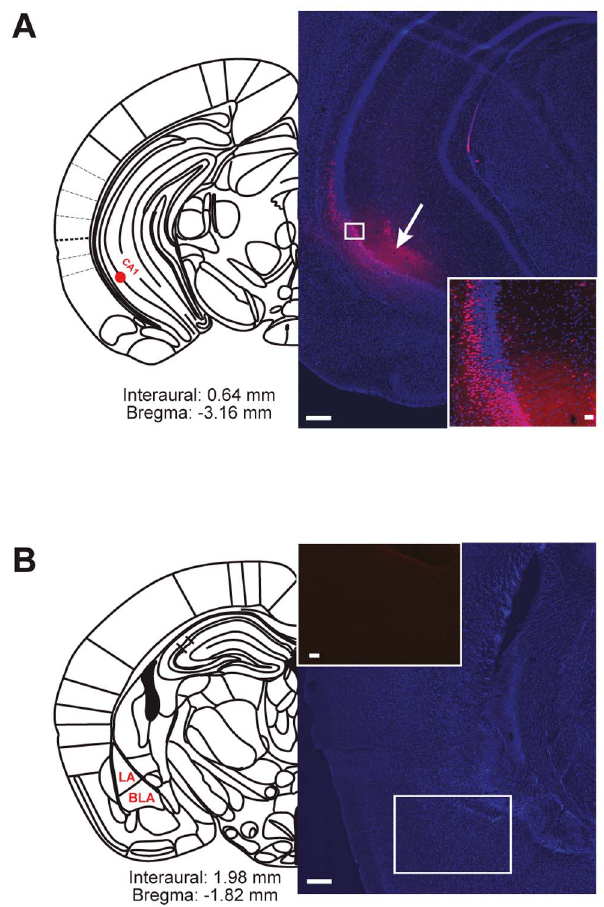
Figure 2. Cy3-NPS is locally restricted to the site of injection into area CA1 of the VH. A, Injection site on an anatomical plate [24]. Overlay of DAPI (nuclear staining, blue) and Cy3-NPS (red) signals. Arrow indicates the injection site in the brain section. B, Anatomical plate showing the lateral (LA) and basolateral (BLA) amygdala, and overview of the amygdala in a brain section after Cy3-NPS injection (inset: Cy3 channel only). n=4. Scale bars, 200 and 20 m m.